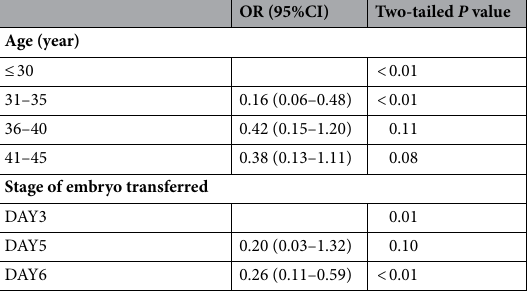
Table 5. Binary logistic regression of influencing factors on live birth rates in the two